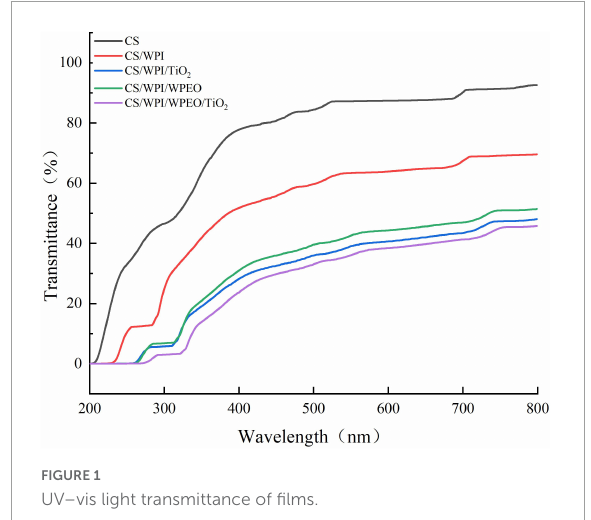
FIGURE1 UV–vis light transmittance of films.